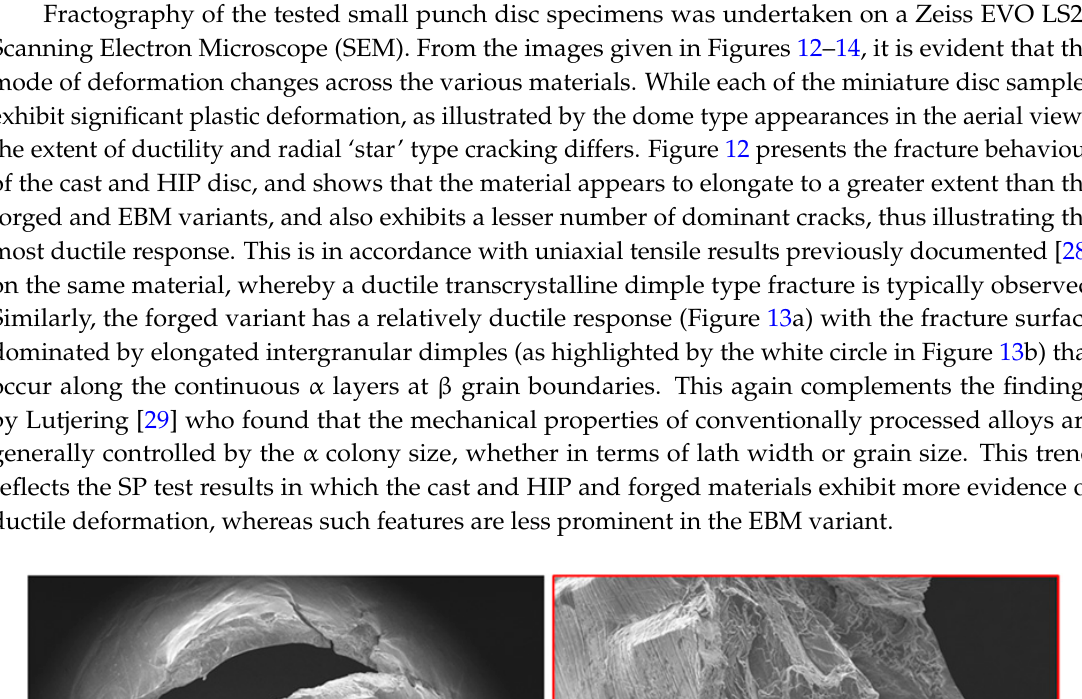
Figure 11. SP tensile response of EBM, cast and HIP and forged Ti-6Al-4V variants at a displacement rate of 0.6 mm·min − 1 .